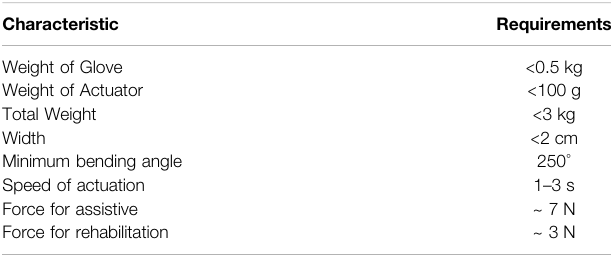
TABLE 1 | | Design requirements for the construction of a soft glove for hand rehabilitation or assistive. Characteristic